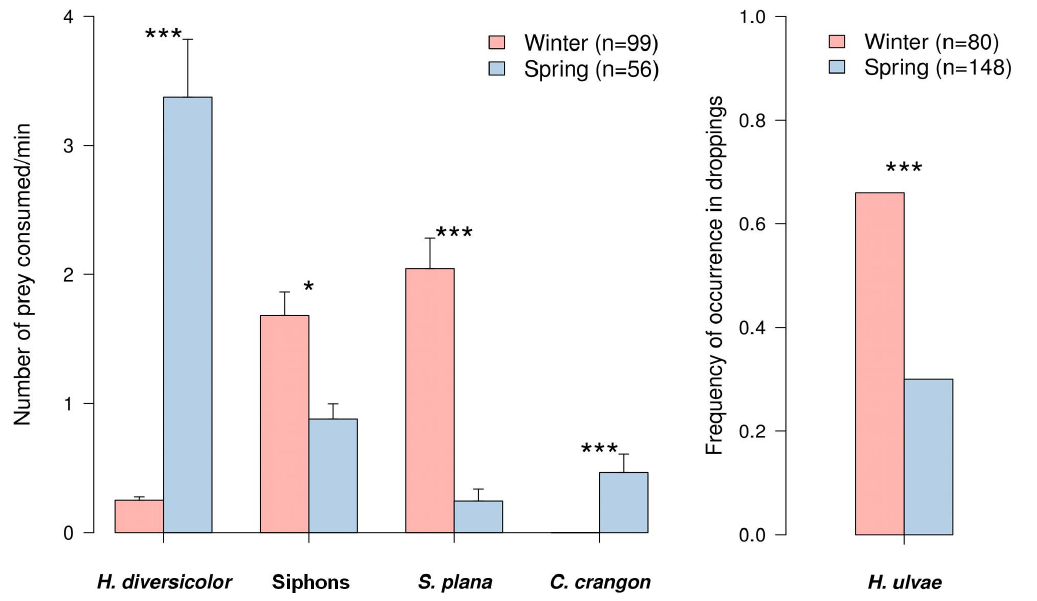
Figure 3. Diet of Dunlin in winter and spring assessed by (A) field observations and (B) dropping analyses. A: Consumption rate (prey/ min) of main prey. B: Occurrence of shell remains of H. ulvae in Dunlin droppings. Values represent mean 6 SE. Differences between seasons were tested with (A) Mann-Whitney (B) and Chi-squared tests (* p , 0.05; *** p , 0.001). doi:10.1371/journal.pone.0081174.g003 Energy Intake Rates of dunlins In spring dunlins achieved energy intake rates 65% higher than wintering birds (Figure 4; Mann-Whitney test: U= 1877, p , 0.001). In winter, whole S. plana was clearly the main source of energy whereas H. diversicolor was the least important. In contrast, in spring H. diversicolor contributed the most energy while whole S. plana played a relatively minor role (Figure 4).